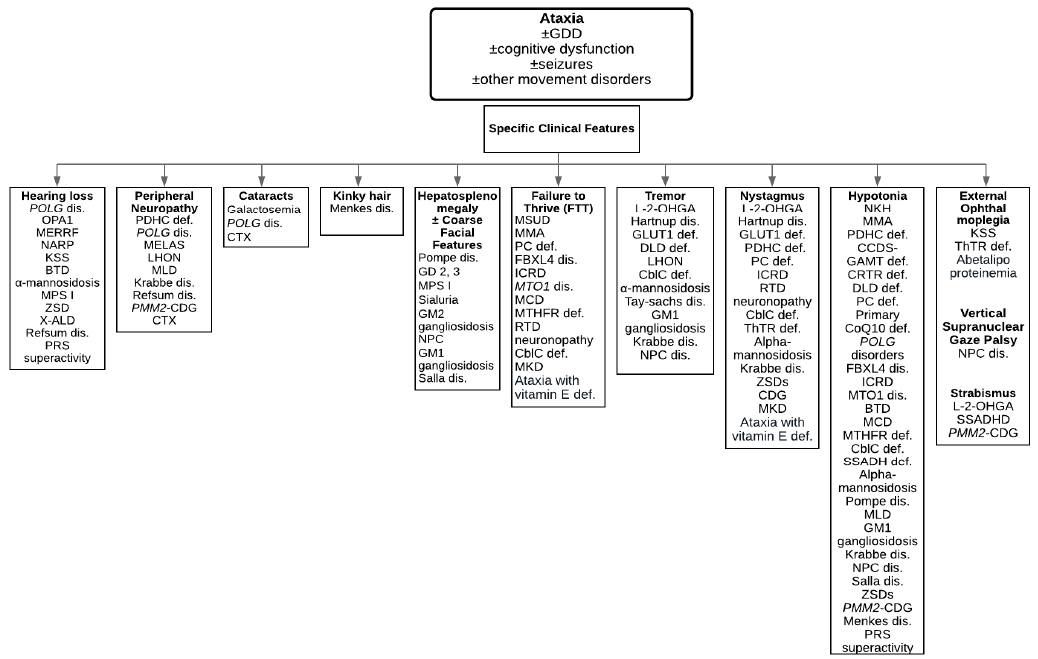
Figure 1. Adiagnosticalgorithmtoguidephysicianstowardscharacteristicclinicalfeatures. Figure 1. A diagnostic algorithm to guide physicians towards characteristic clinical features.